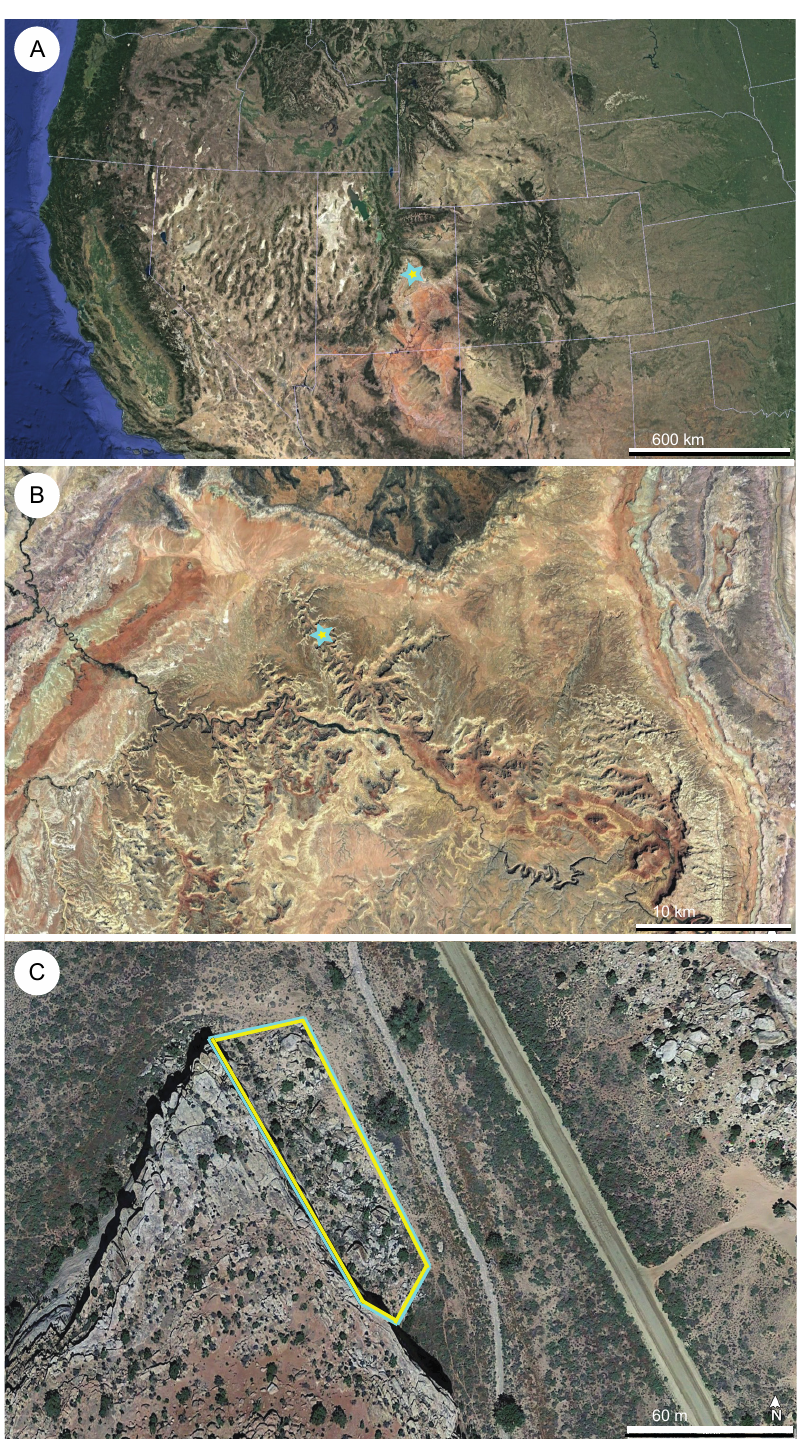
Figure 2. (previous page). Overview of sampling location in Buckhorn Wash, Emery County, Utah, USA. ( A ) Blue-outlined star indicates sample site within the broad context of western North America and the location of the site on the northwestern edge of the Colorado Plateau; ( B ) satellite view of the “Semiarid Benchlands and Canyonlands” ecoregion in the San Rafael Swell, with the sample site being marked in a blue-outlined star; ( C ) the location of the sample site in relation to Buckhorn Wash Road, with the targeted area being outlined in